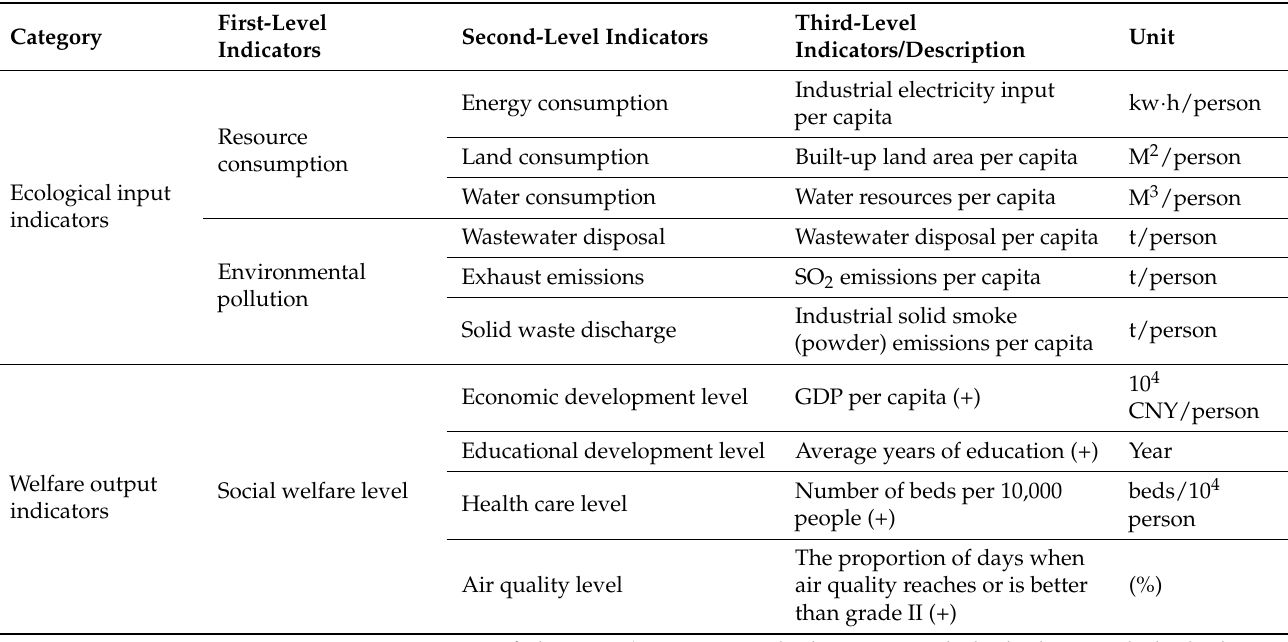
Table 2. Input–output index system of ecological welfare